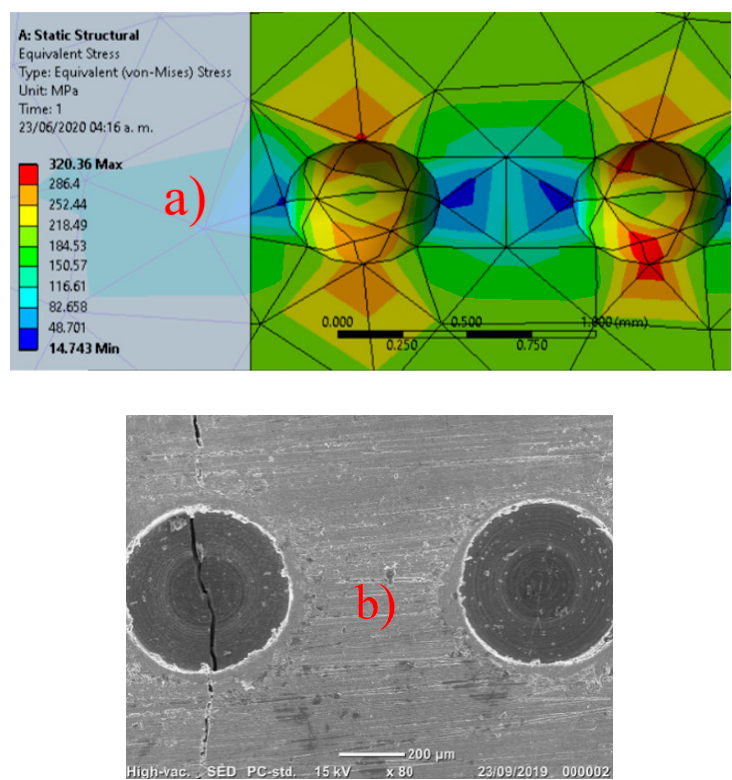
Figure 14. ( a ) Stress distribution for two pits in longitudinal direction and 130 µ m of total displacement; ( b ) fracture on two pits in longitudinal direction.